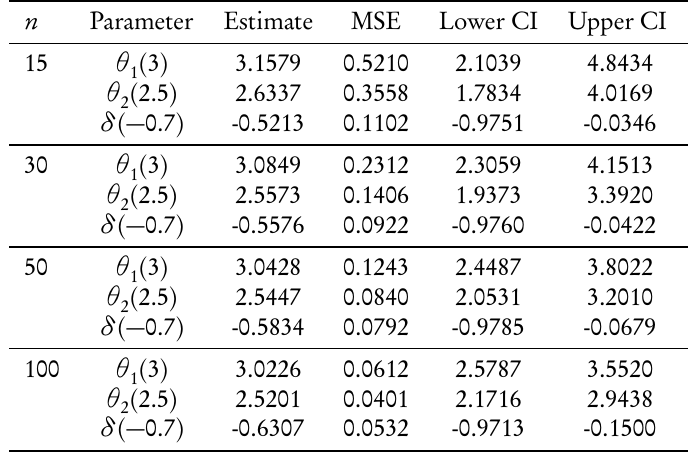
Simulation study of the parameters of BXG distribution (Case 4 - MLE).